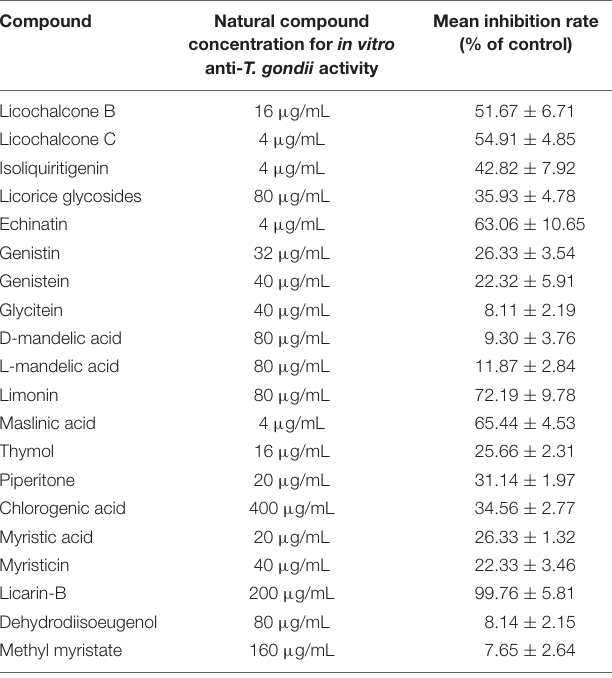
TABLE 2 | Screening of anti- T. gondii activity of natural compounds in vitro .